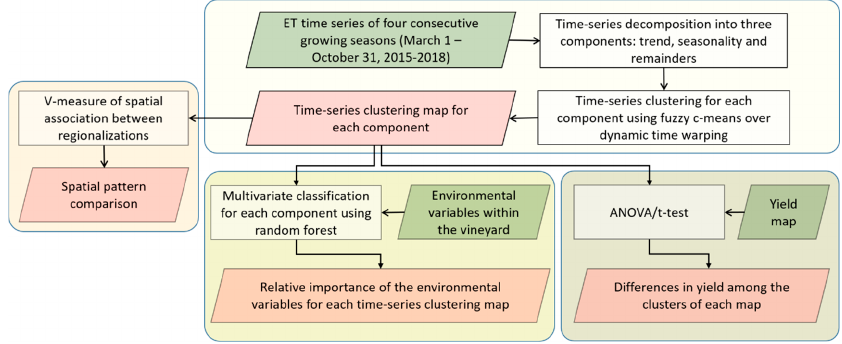
Figure 2. Flowchart of the research framework.